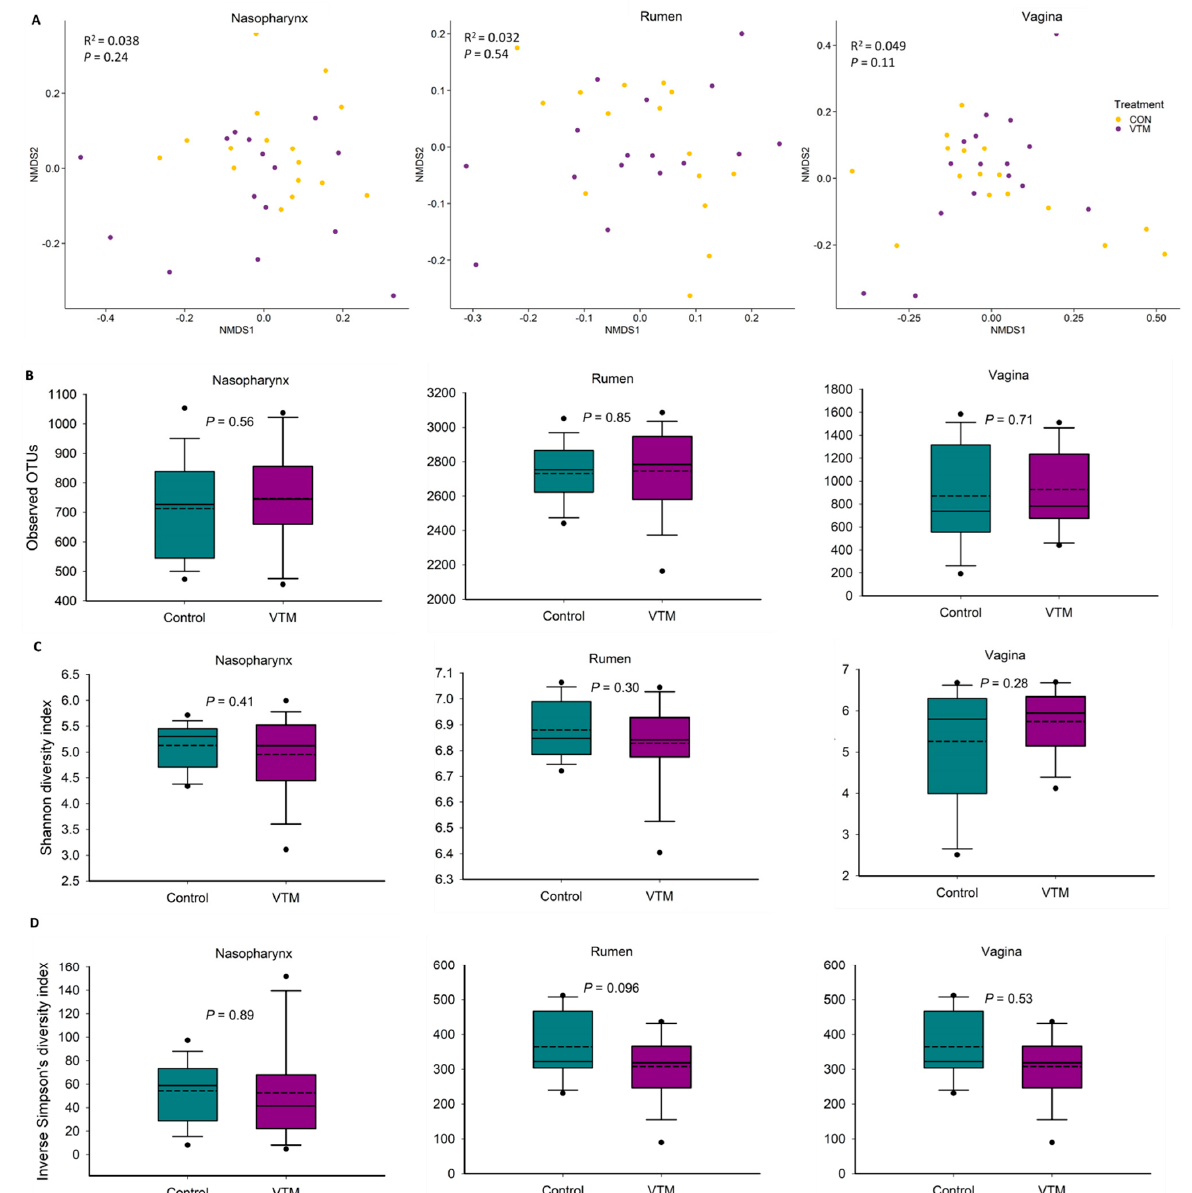
Figure 2. Beta and alpha diversity of the nasopharyngeal, ruminal and vaginal microbiota of pregnant heifers that received a vitamin and mineral supplement (VTM) or a control diet (Control) during the first six months of gestation. ( A ) Non-metric multidimensional scaling (NMDS) plots of the Bray–Curtis dissimilarities, ( B ) number of operational taxonomic units (OTUs), and Shannon ( C ) and inverse Simpson’s diversity index ( D ) of each microbial community.